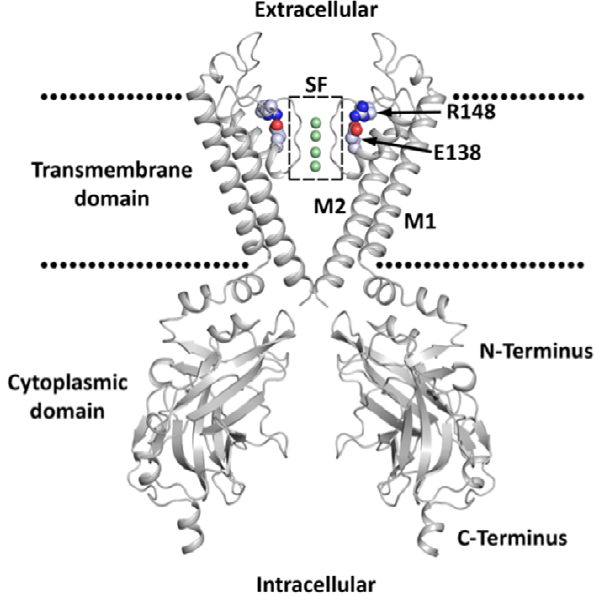
Figure 1. Two opposing domains of the K IR channel with structural common features highlighted. The membrane is indicated by dotted lines. The selectivity filter (SF) is highlighted by a dotted box. Ions inside the SF are shown as green spheres. Residues E138 and R148 (K IR 2.1) are shown as